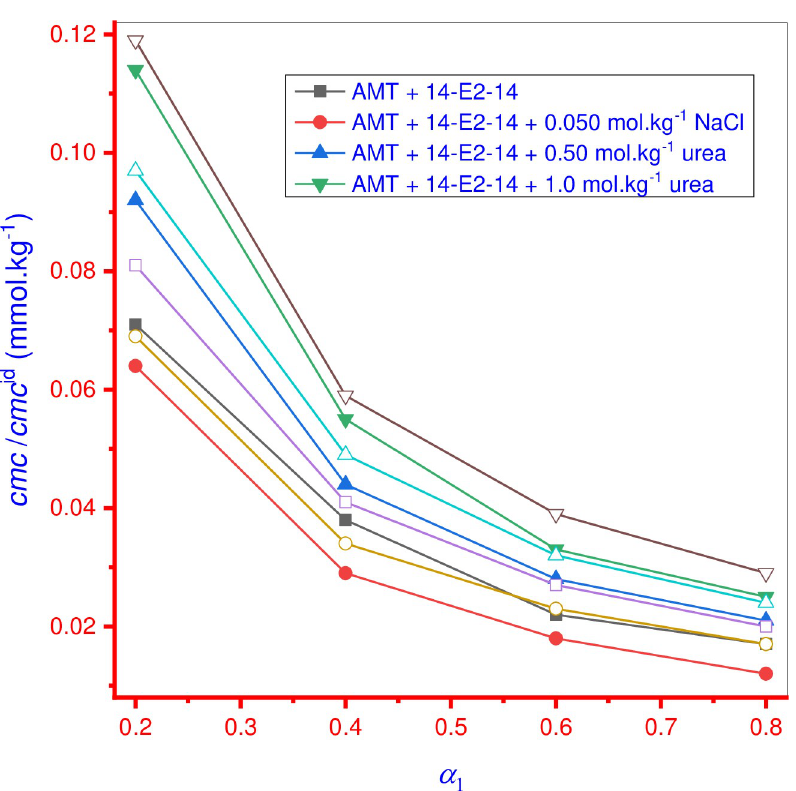
Fig 2. Change of cmc / cmc id value of AMT+14-E2-14 mixed system vs. mole fraction ( α 1 ) of 14-E2-14 (filled symbol for experimental cmc and open symbol for cmc id ).